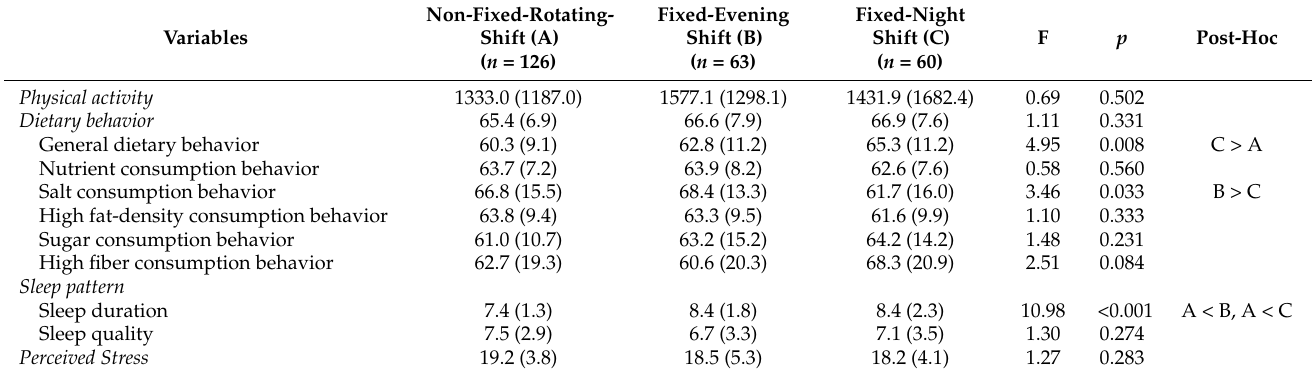
Table 3. Comparison of lifestyle patterns between the different types of rotating shifts ( n = 249).